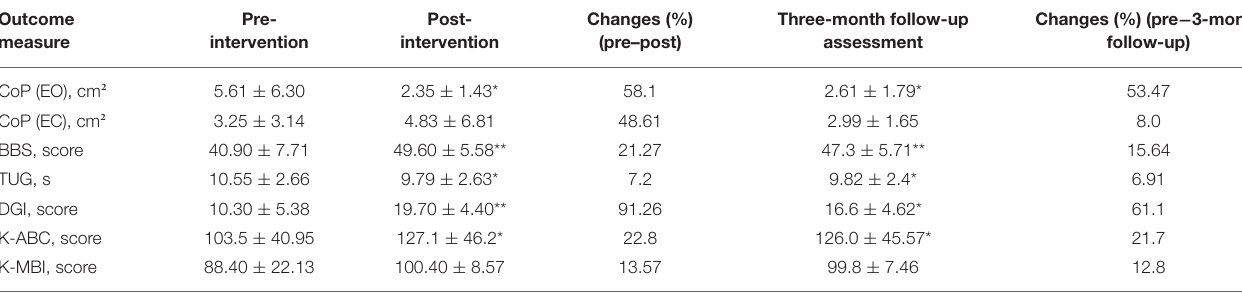
TABLE 3 | Comparison of the post-intervention and 3-month follow-up outcomes with baseline. Outcome